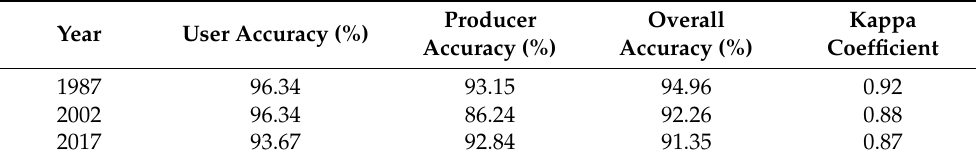
Figure 4. Classification of LULC classes during (1987–2017). Table 3. Accuracy assessment of the classified land cover maps for 1987, 2002, and